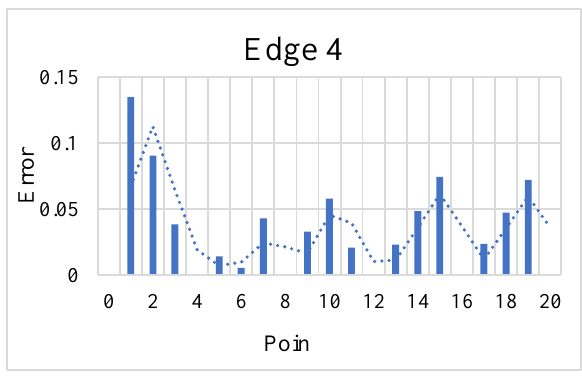
Graph 2. Deviations of the nodal points from the nominal ones for result 4.